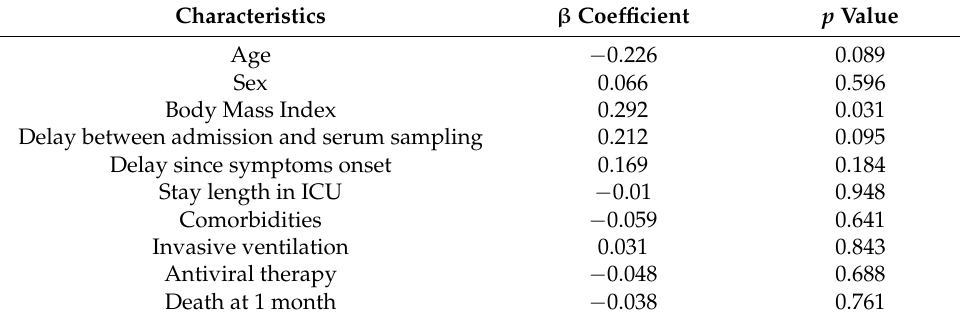
Table 3. Factors associated with neutralizing antibody titers in ICU patients (linear regression).